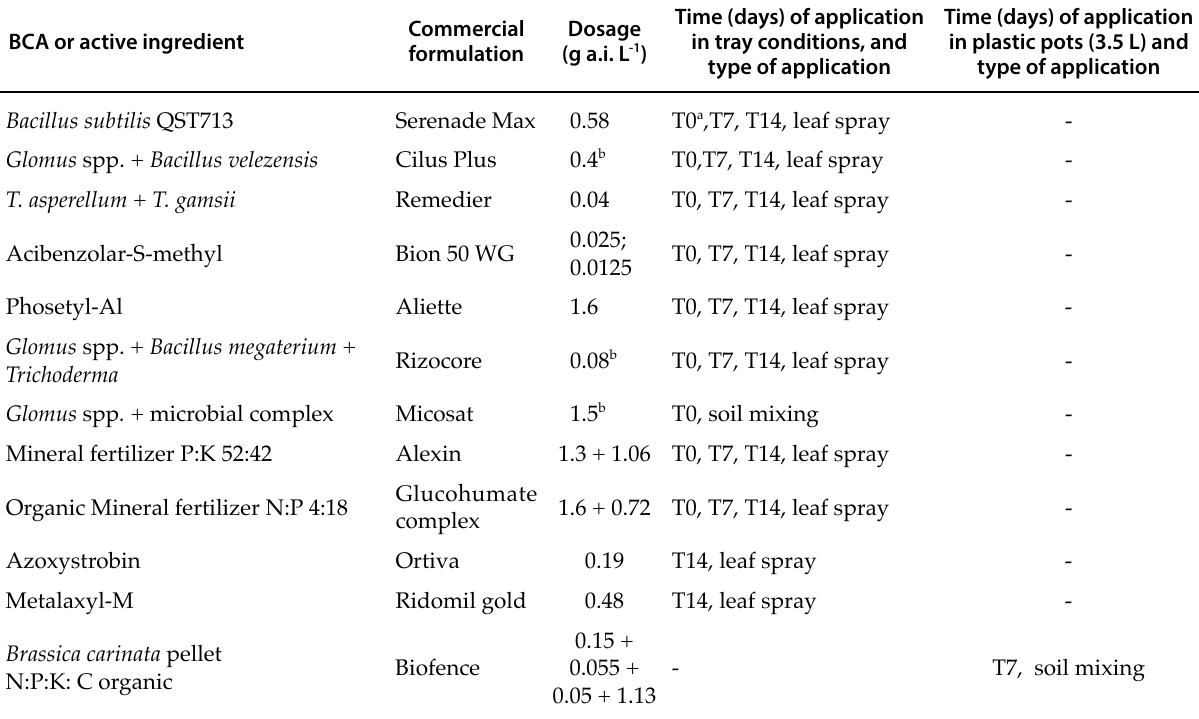
Table 2. List of the products tested and experimental protocol used for treatments applied to tomato plants. Commercial BCA or active ingredient